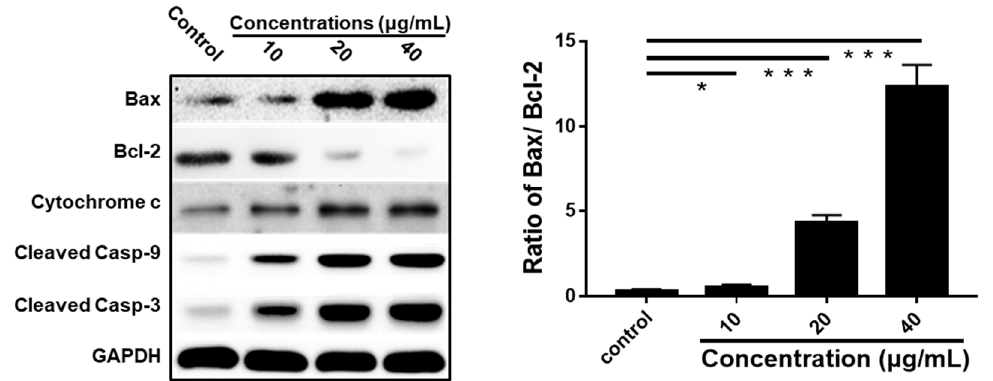
Figure 6. Western immunoblot analysis of the expressions of Bax, Bcl-2, cytochrome c , cleaved caspase-9, and cleaved caspase-3 on DU145 cells. Cells were treated with LEGCG for 24 h. *, 0.01 < p < 0.05; **, 0.001 < p < 0.01; ***, p < 0.001.